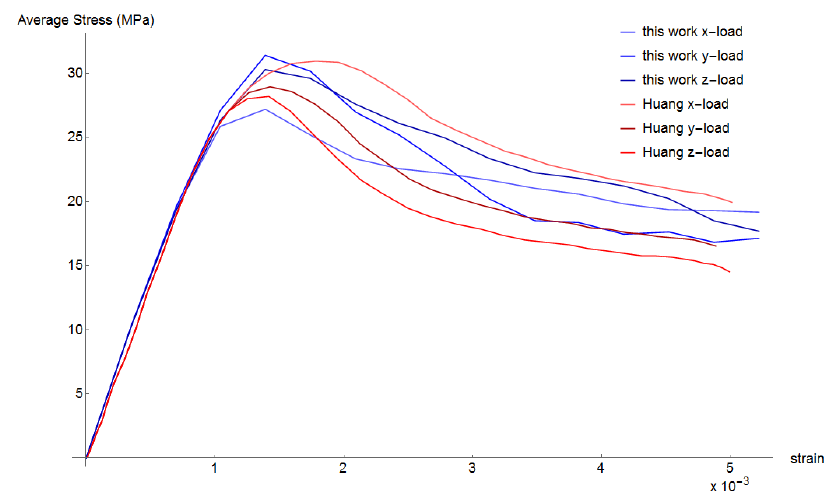
Figure 7. Simulated stress–strain curves for uniaxial comparison.